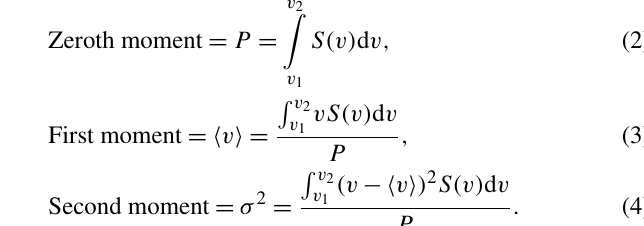
Figure 1. Wind rose from the 30min mean winds measured by the sonic anemometer on the northwest boom at 200m on the BAO tower. Waked measurements have been removed and appear as a gap in observations around 154 ◦